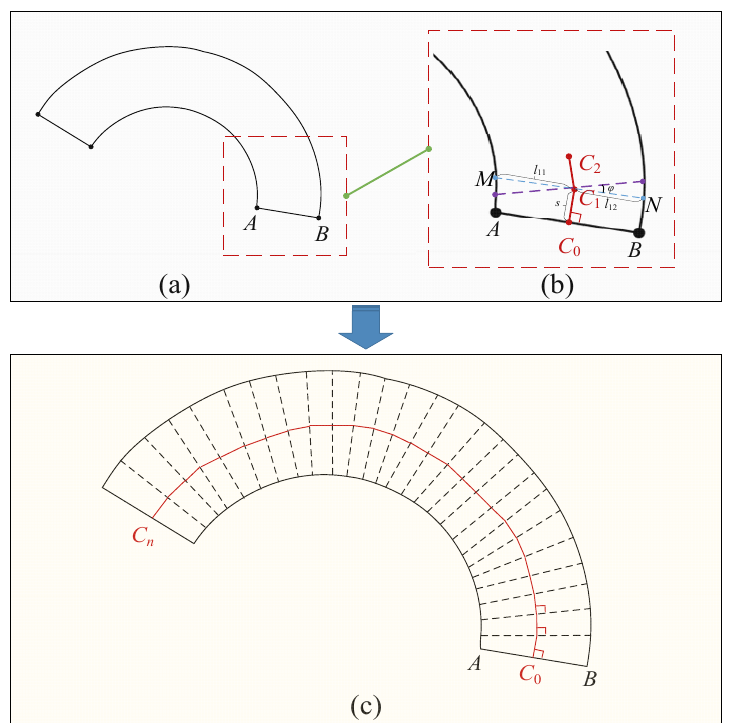
Figure 10. Illustration of the algorithm logic for generating the X-Z topological path: ( a ) extracted boundary of the projected spiral stair, ( b ) details of path generation, and ( c ) X-Z topological path generated by the novel solution.